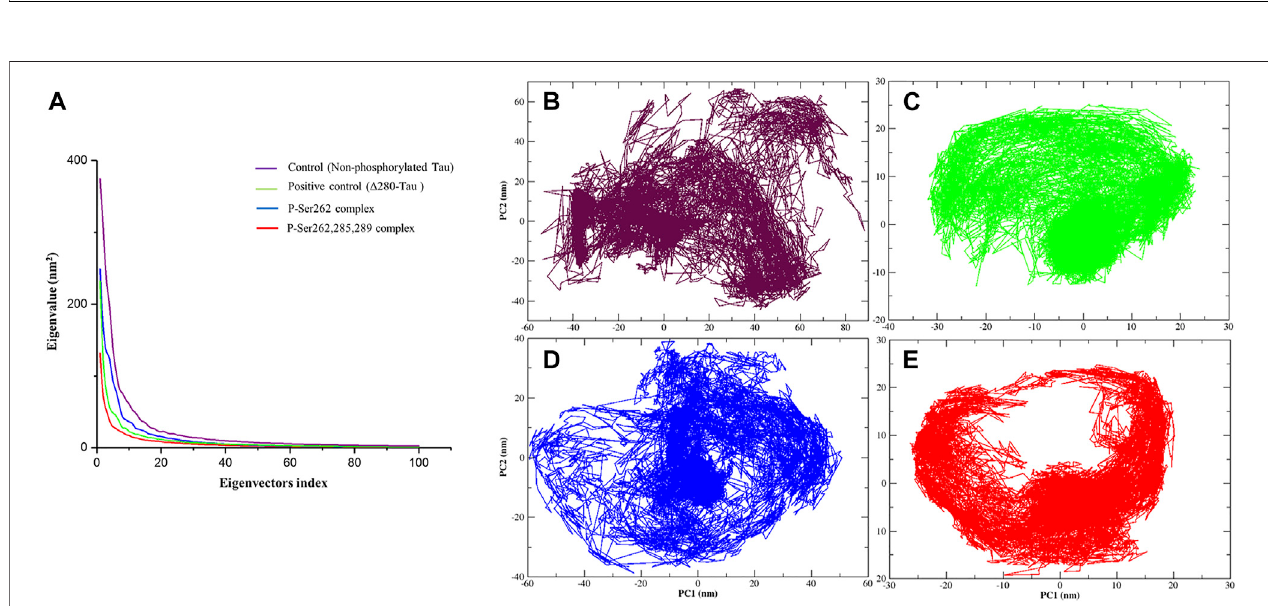
FIGURE 5 | Principal component analysis (PCA) of the C α atomic fl uctuations in the control (non-phosphorylated tau), positive control ( Δ 280-tau), and the complexes with one (P-Ser262) and three (P-Ser262, 285, and 289) phosphorylated sites during 200 ns simulations. (A) Eigenvalues were plotted against the eigenvectors. Projections of the trajectory of (B) control and (D) P-Ser262 showed more changes compared to (C) positive control and (E) P-Ser262, 285, 289.